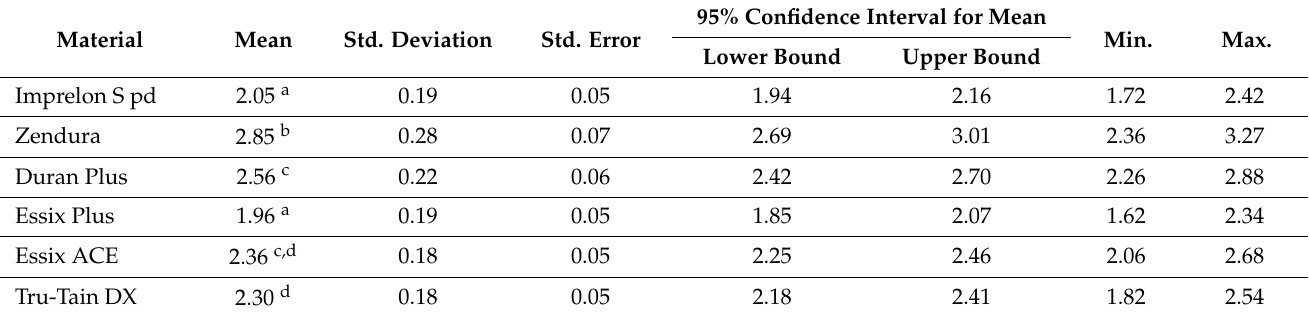
Table 5. Descriptive analysis of flexural modulus values of Group 2 (the same small letter indicates no significant difference between the materials at p < 0.05 level).